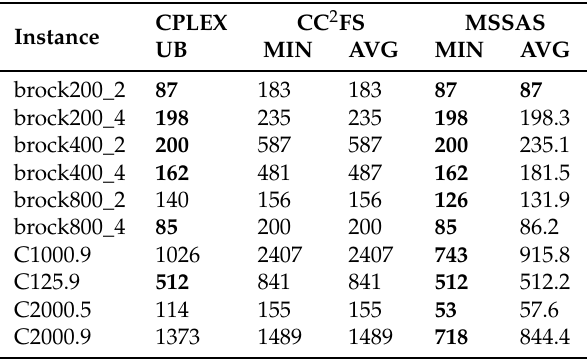
Table 2. Experimental results of CPLEX, CC 2 FS and MSSAS